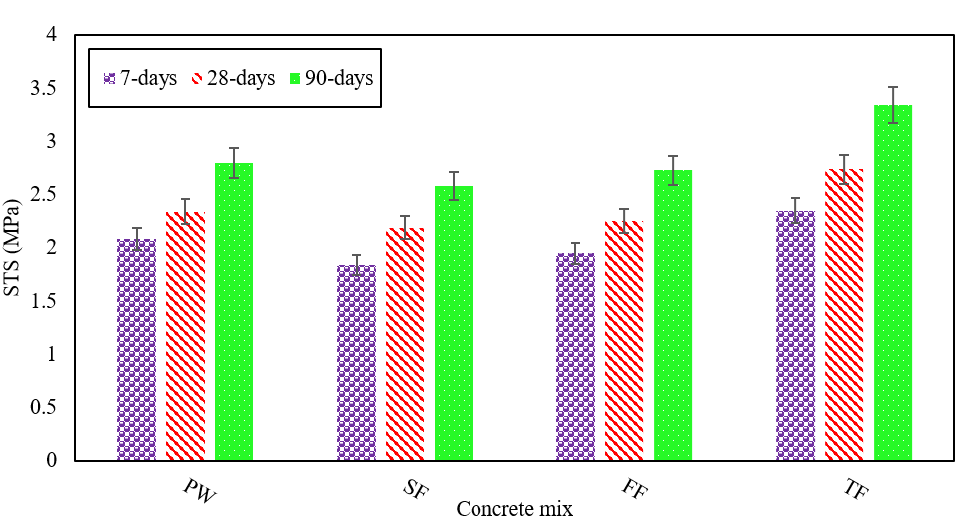
Figure 4. STS of various RAGC mixes at 7, 28, and 90 days of testing.